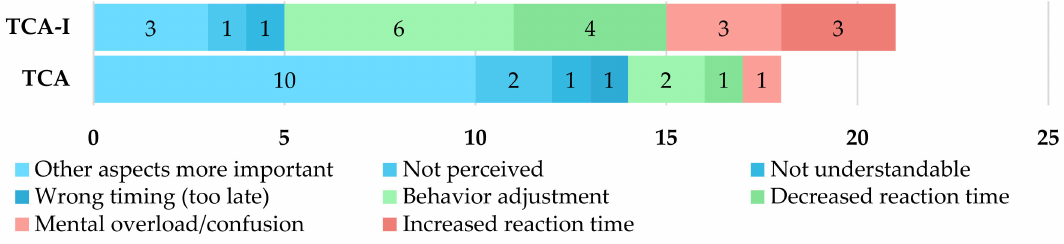
Figure 10. Experienced behavior change: distribution of results according to test condition. (Interview question